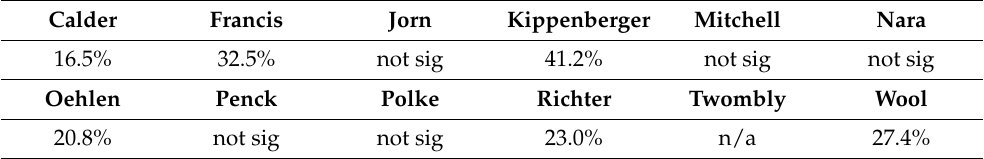
Table 5. Percentage change in price through selling at Sotheby’s or Christie’s compared to other auction